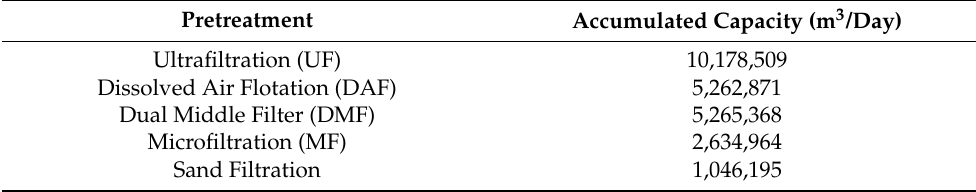
Table 4. Typical pretreatment methods in the RO plants